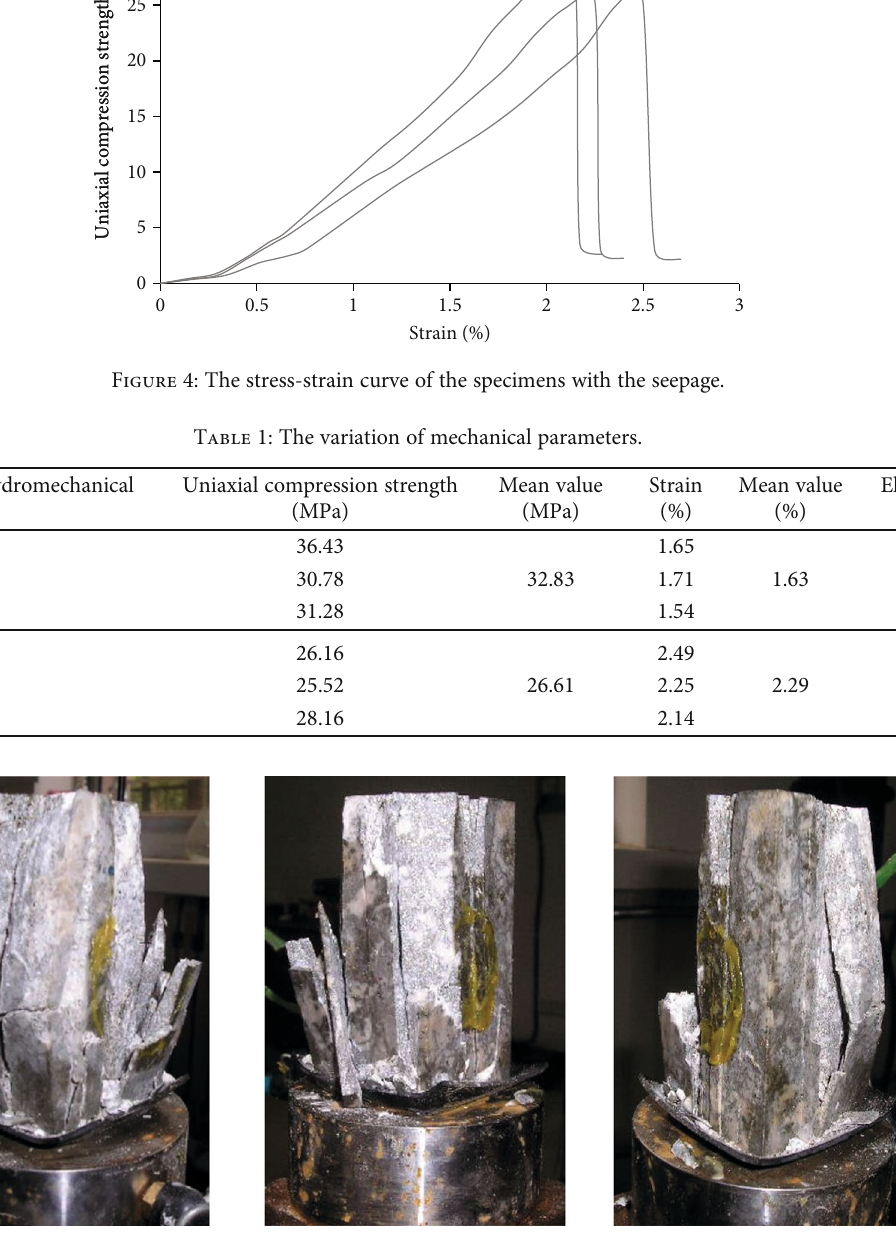
Figure 5: Failure patterns of the specimens under pure uniaxial compression